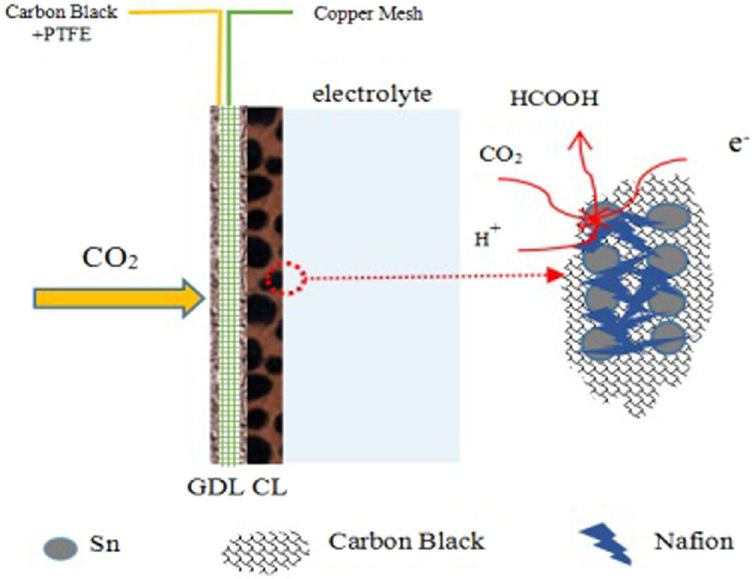
Figure 1. Schematic diagram of the